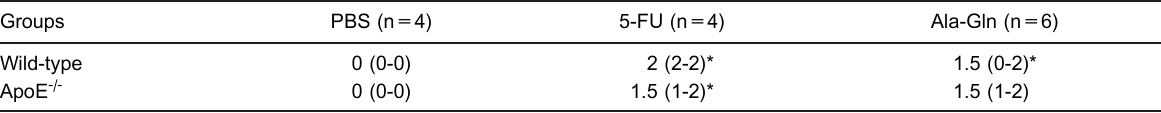
Table 4. Necrotic crypt scoring in mice with or without 5-fluorouracil challenge. Groups